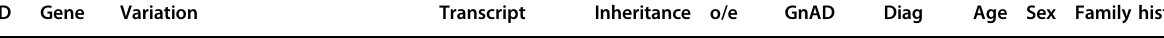
Table 3 Nucleotide variants conferring susceptibility for autism (strati fi ed by category) identi fi ed among the 253 ASD subjects. Nucleotide variants in genes harboring a statistically signi fi cant excess of de novo PTVs were classi fi ed either as susceptibility variants in class A genes (false discovery rate (FDR) <5%) or as probable susceptibility variants in class B genes (10% < FDR < 5%). Nucleotide variants in syndromic ASD – related genes were classi fi ed using the guidelines from the American College of Medical Genetics-Association for Molecular